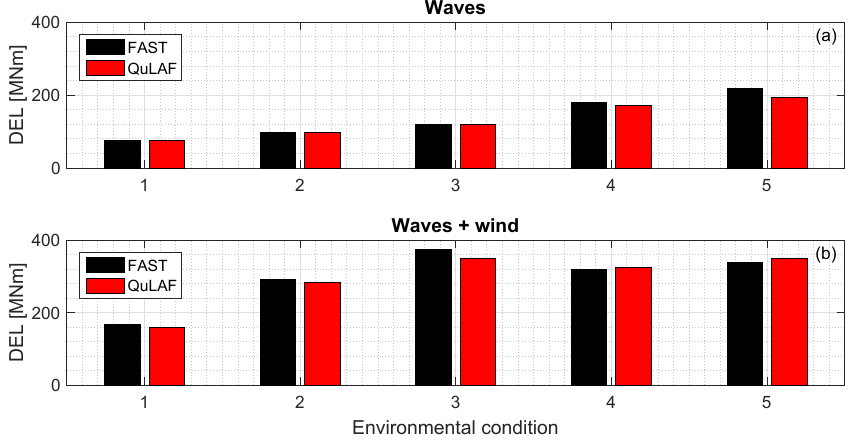
Figure 11. Damage-equivalent bending moment at the tower base for different environmental conditions.